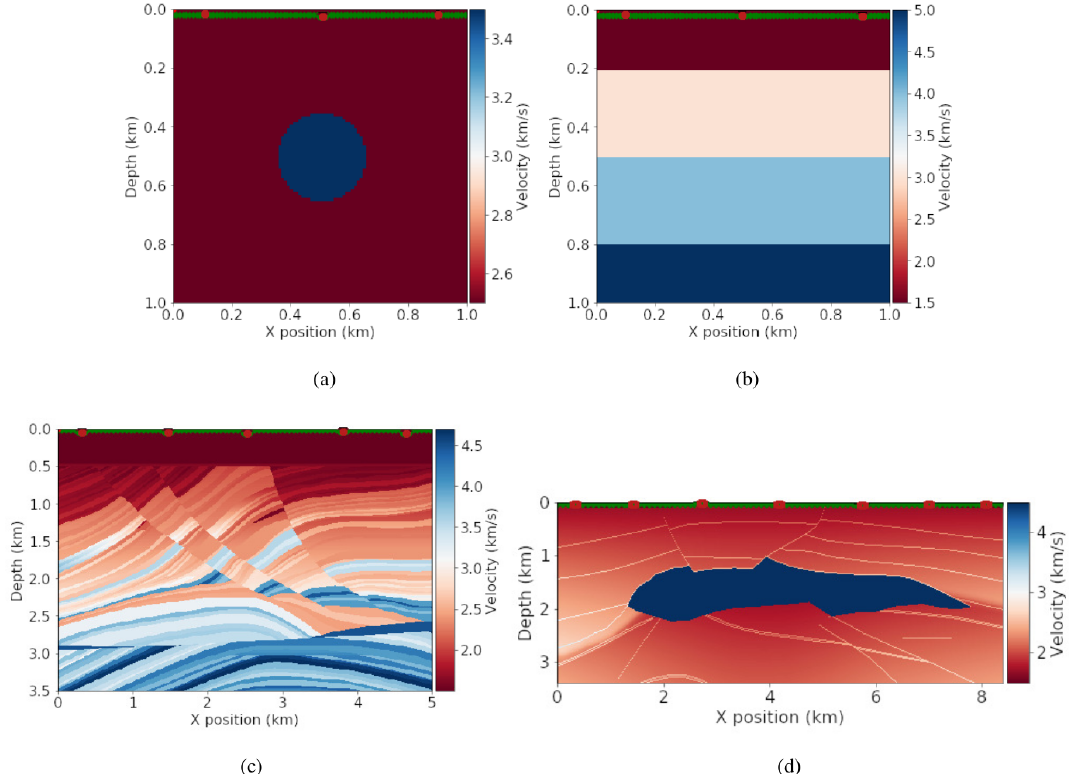
Figure 5. Velocity models are shown as (a) a circle, (b) horizontal layers, (c) part of the Marmousi, and (d) the 2D SEG/EAGE. The red points illustrate the source positions, and the green points illustrate the receiver positions.